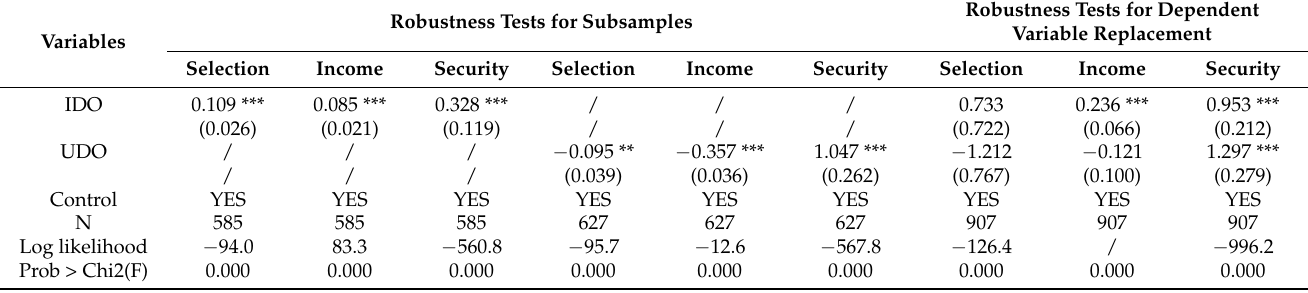
Table 3. Results of robustness